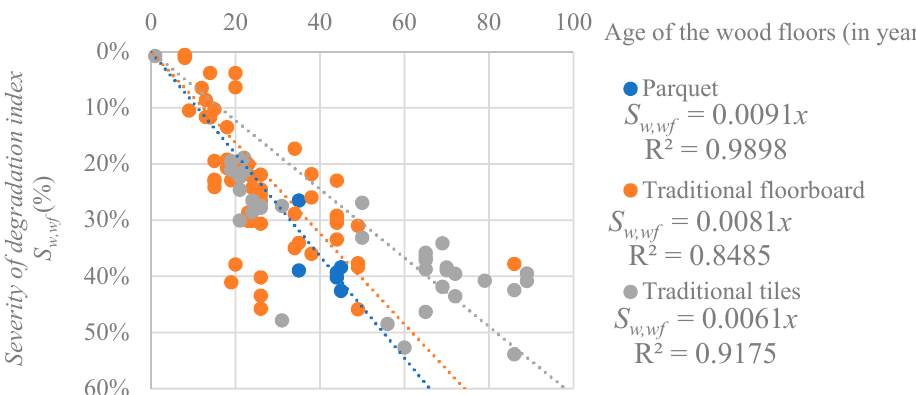
Figure 5. Regression analysis between the numerical index that expresses the degradation of the 96 wood flooring systems ( S w,wf ) and their age, according to the type of flooring system.